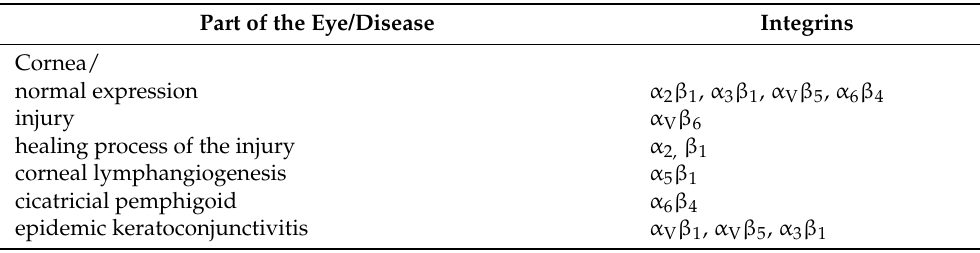
Table 1. Integrins involved in the normal eye and eye